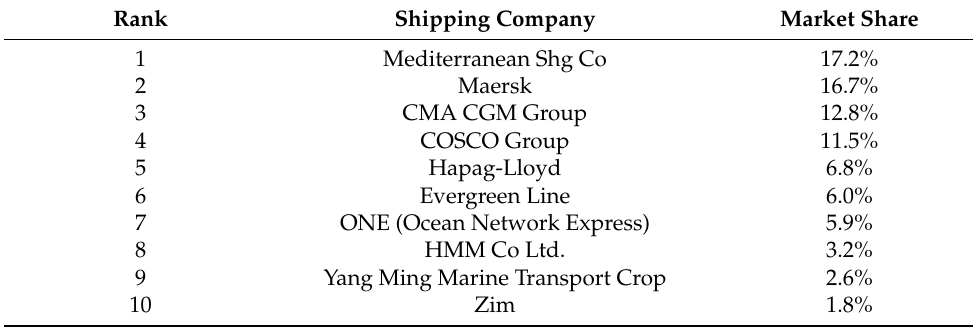
Table 2. Top 10 container shipping companies in the world as of